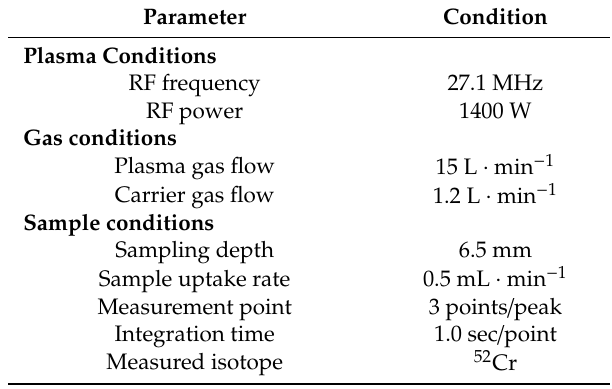
Table 1. Operating conditions of inductively coupled plasma mass spectrometry